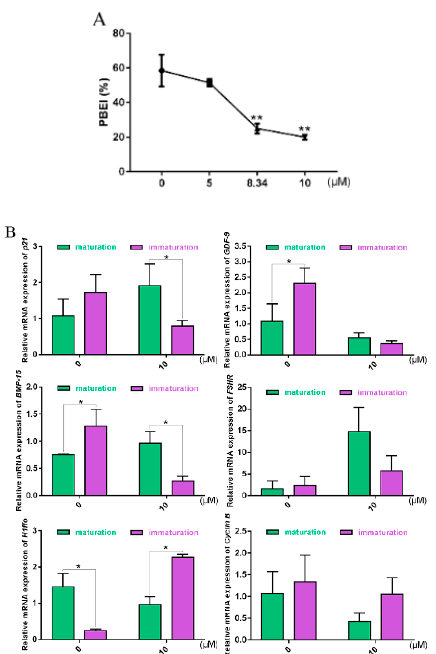
Figure 6. Effects of the ataxic telangiectasia mutation (ATM)-specific inhibitor KU-55933 on bovine COCs: ( A ) PBEI% of bovine COCs with different concentrations of KU-55933 treatment for 22 h; ( B ) after bovine COCs were treated with 10 μ M KU-55933 for 22 h, the oocytes at PBEI (“maturation”, green charts) and oocytes at GV (“immature”, purple charts) were collected, in order to detect the genes for oocyte quality evaluation and cell cycle. * indicates p < 0.05, ** indicates p < 0.01.